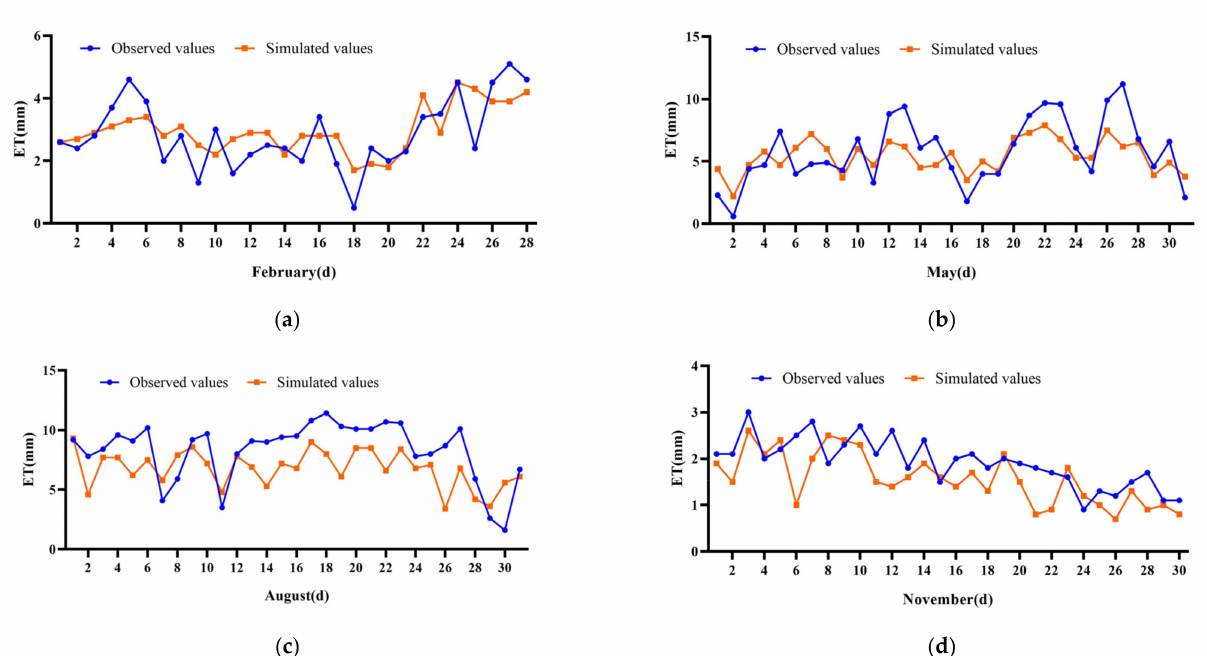
Figure 4. Comparison of simulated and observed values. ( a – d ) are the observed and simulated values in February, May, August, and November, respectively.